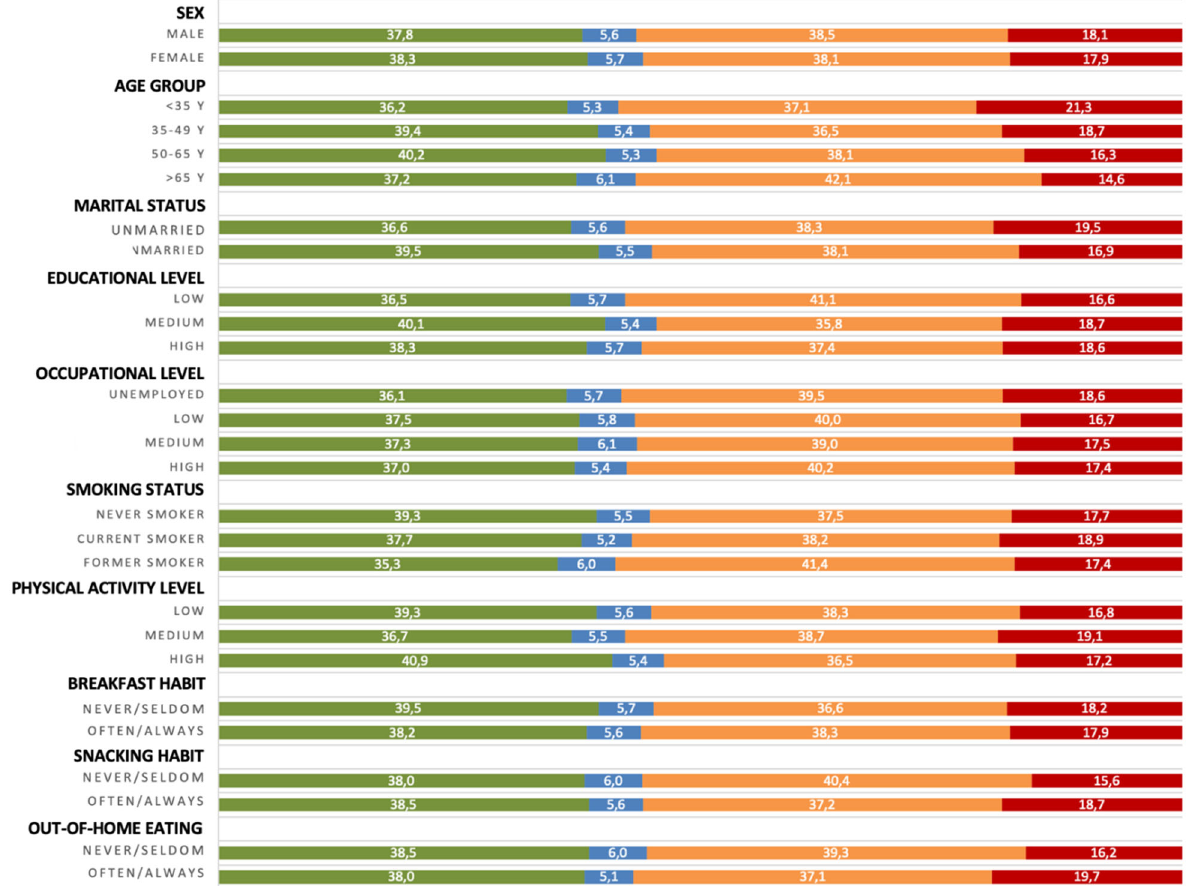
Figure 1. Percent distribution of food group consumption by level of processing across background variables. Green color stands for unprocessed/minimally processed foods; blue color stands for processed culinary ingredients; brown color stands for processed foods; red color stands for ultra- processed